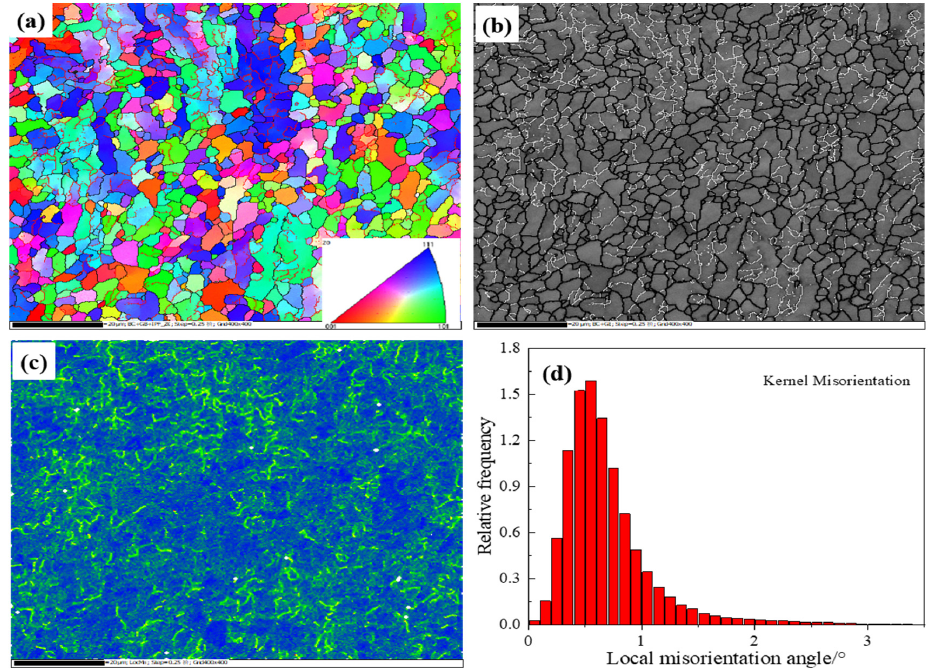
Figure 8. EBSD maps of the pipeline steel isothermal quenched at 480 °C. ( a ) IPF map; ( b ) large and small angle grain boundary; ( c ) KAM map; ( d ) Local misorientation.